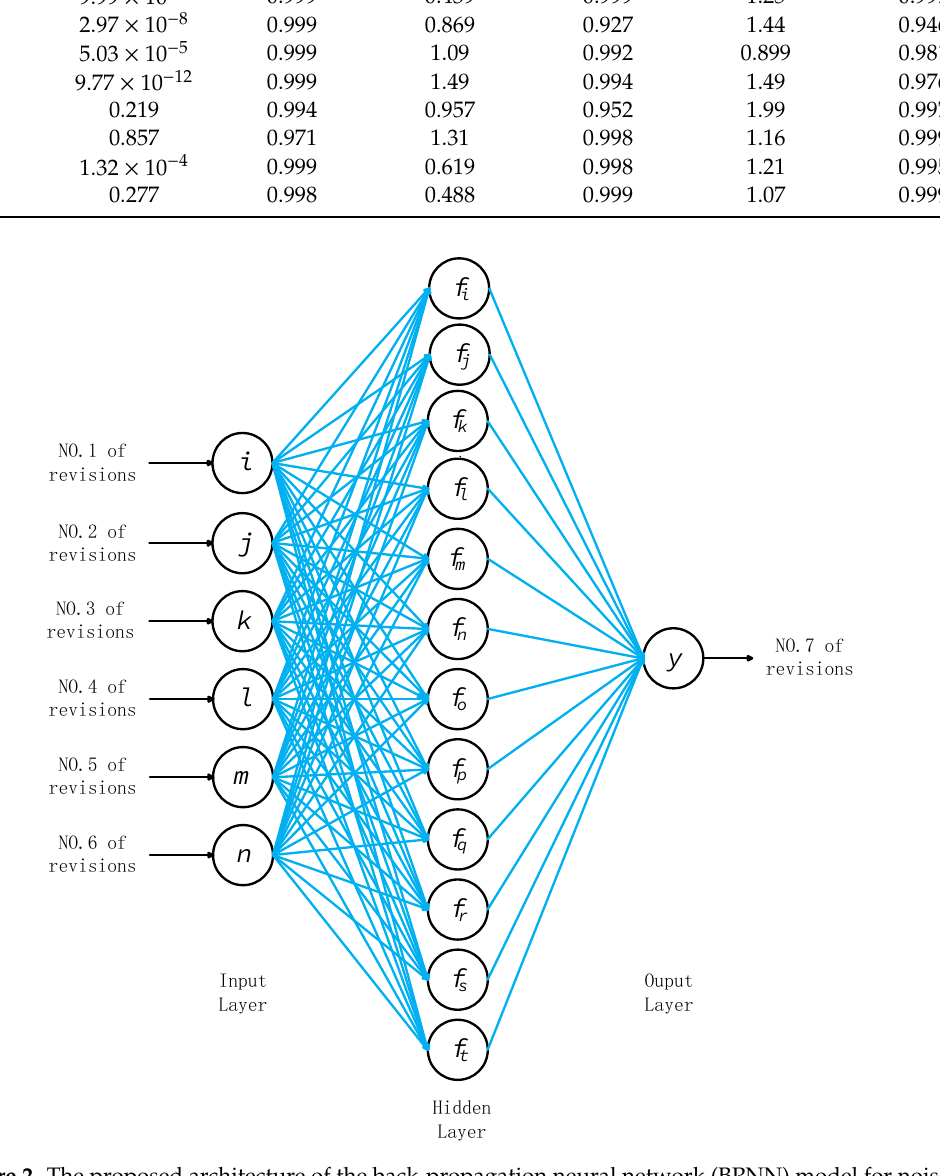
Figure 2. The proposed architecture of the back-propagation neural network (BPNN) model for noise limits during vehicle acceleration (6–12–1).